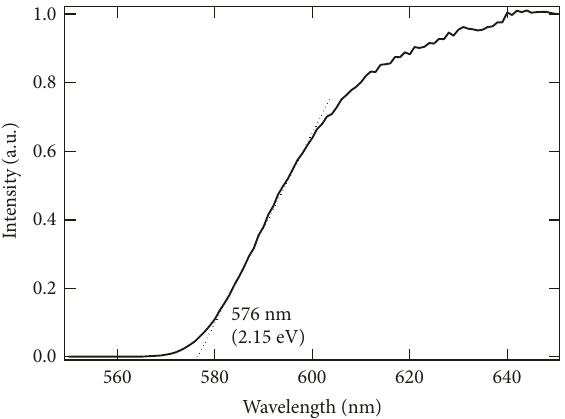
Figure 4: Transmittance spectrum of a cleaved SbI 3 crystal.